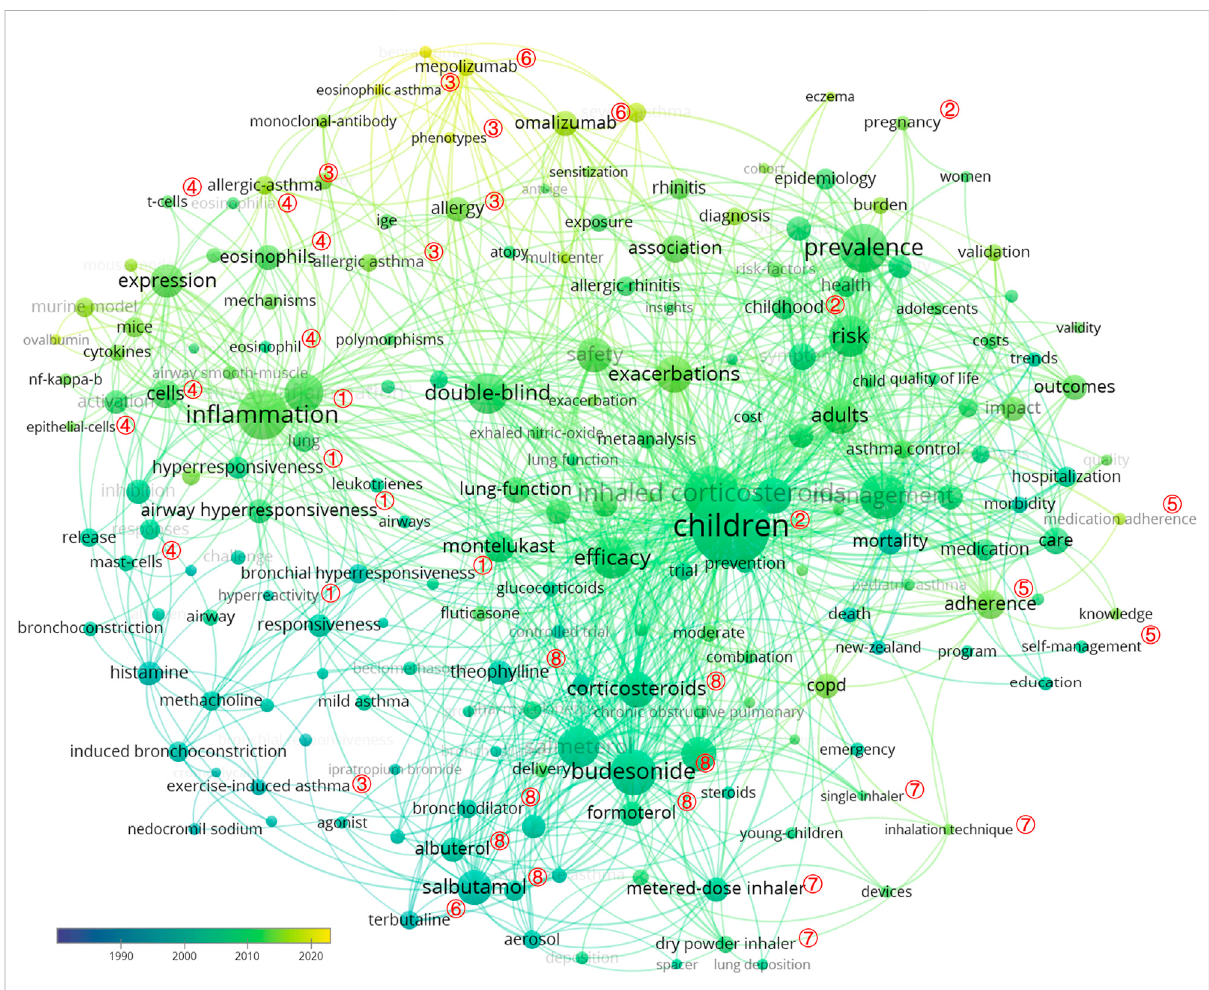
FIGURE 5 VOSviewernetworkmapofco-occurrenceanalysisofallkeywordsofasthmadrug-relatedstudies.Notes: ① thebasisofasthma:in fl ammation,